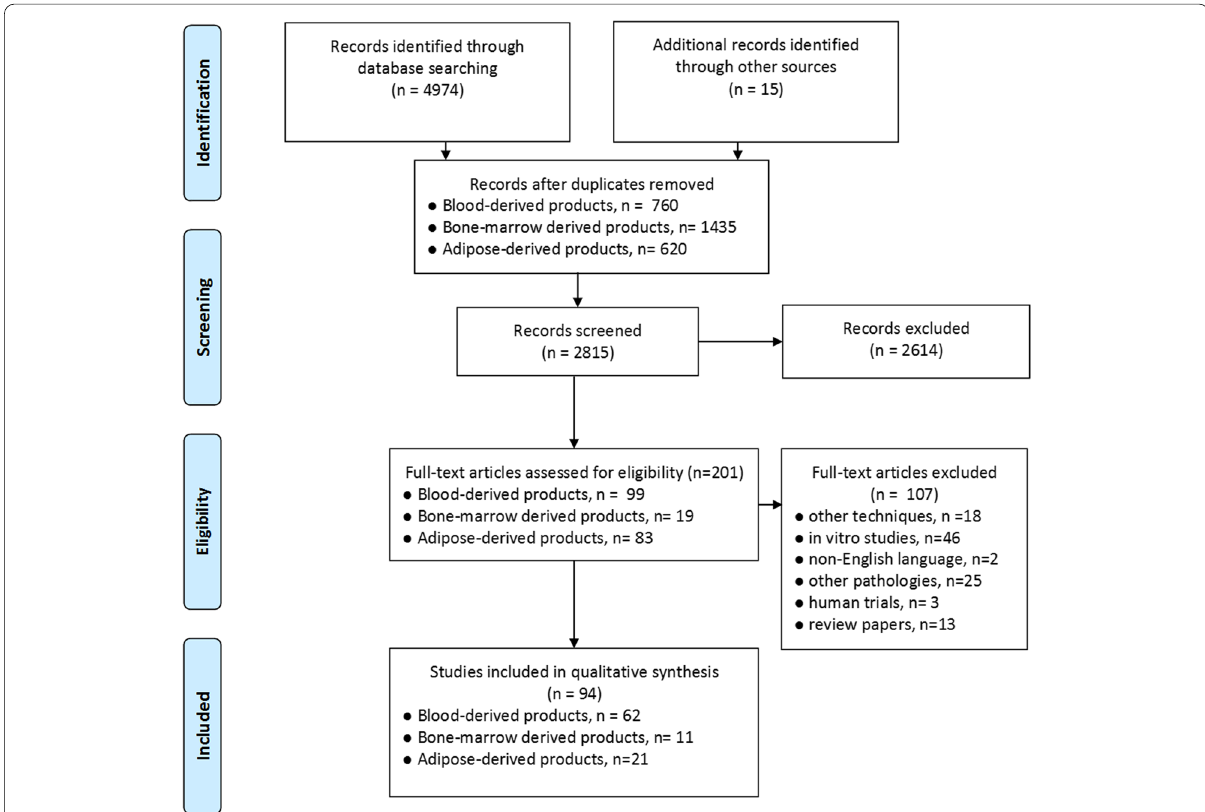
Fig. 1 PRISMA flow-chart summarizing study selection